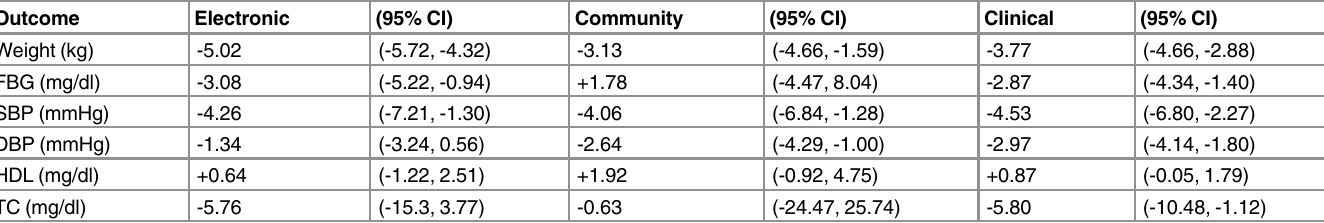
Table 4. Outcomes stratified by type of provider for delivery of the intervention. (Supporting forest plot in S8 Fig.)